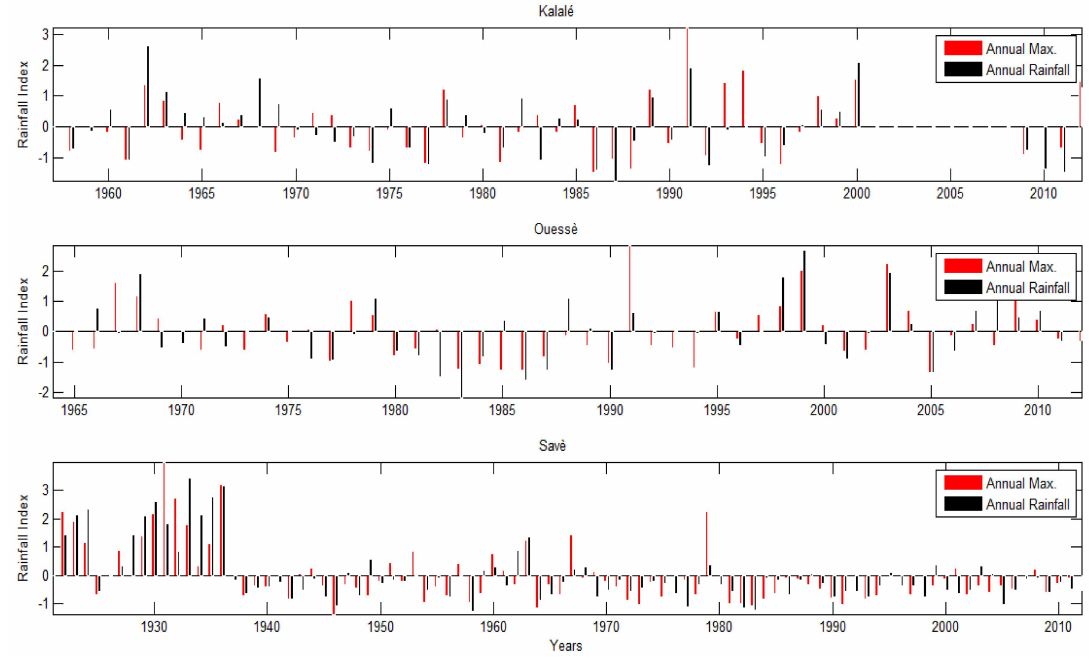
Figure 8. Standardized precipitation index (SPI) and standardized extreme precipitation index (SEPI) for three stations (Kalalé, Ouèssè, and